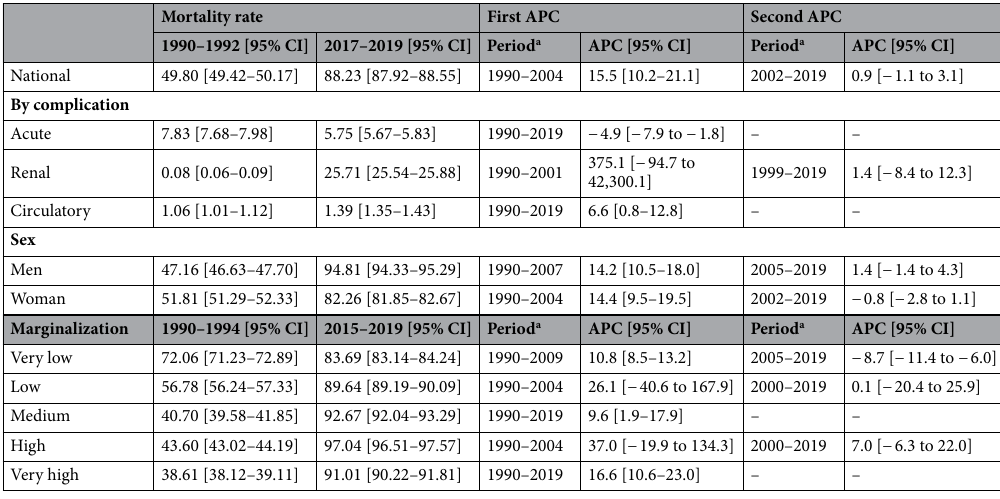
Table 1. Mortality rate and annual percentage change for diabetes mellitus in Mexico. Because it was categorized into periods, the first and second APC overlaps with the end and the beginning of the period where the inflection point was found. The start of the second APC is at the beginning of the period where the inflection point is found. The first APC ends at the end of the period where the inflection point is found. APC annual percentage change, CI confidence interval. a The two annual percentage changes mark the beginning and end of each period until the turning